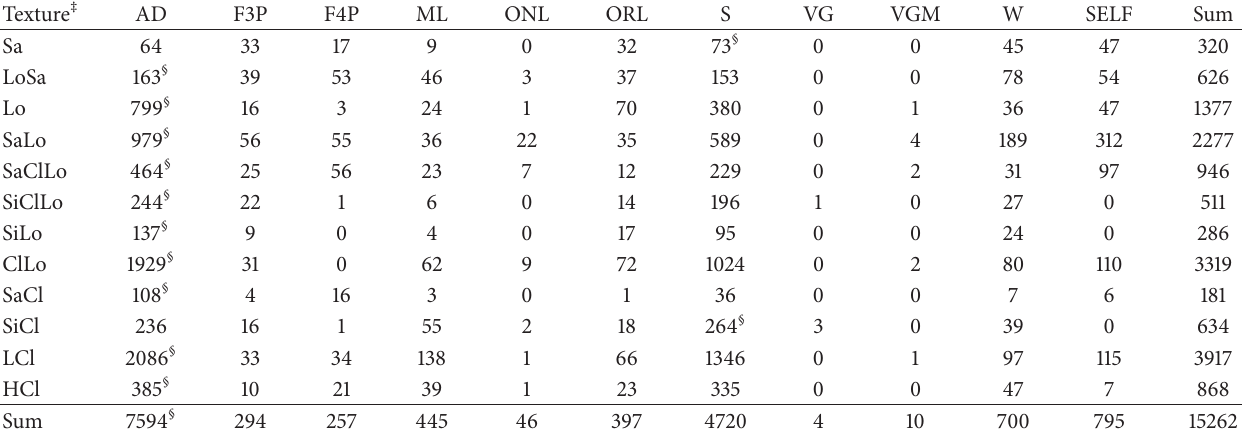
† For example, if the best model according to AIC value of a soil sample is the AD model, the number of the AD model in the table will increase by one. If a model has a big number in a soil textural class, it has advantages in fitting the PSD curve compared to models with small number. The compared eleven